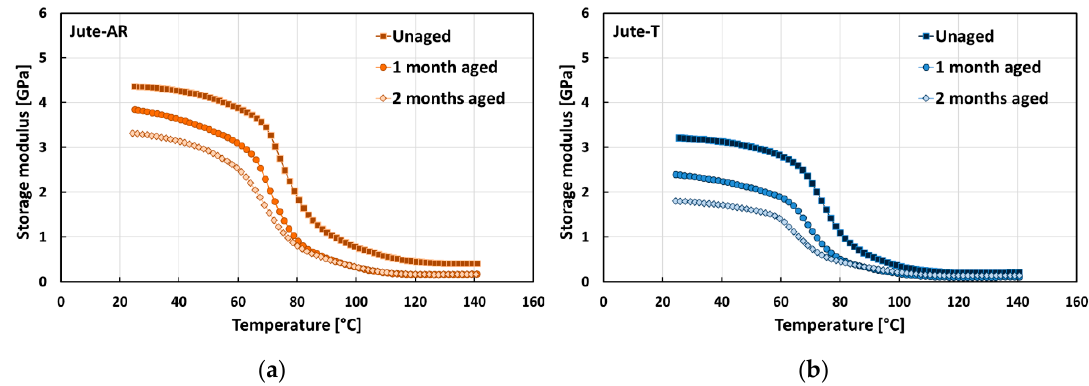
Figure 4. Typical storage modulus trends of jute composites in each aging condition: ( a ) Jute-AR composites; ( b ) Jute-T composites.